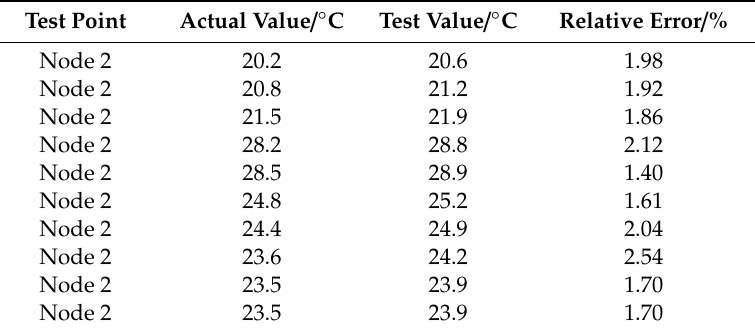
Table 5. Temperature test data.